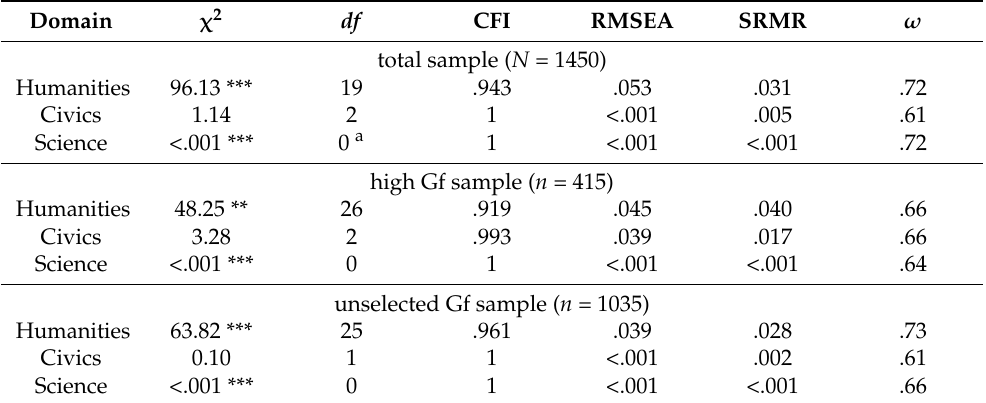
Table 5. CFA and Omegas of Knowledge Domains (All